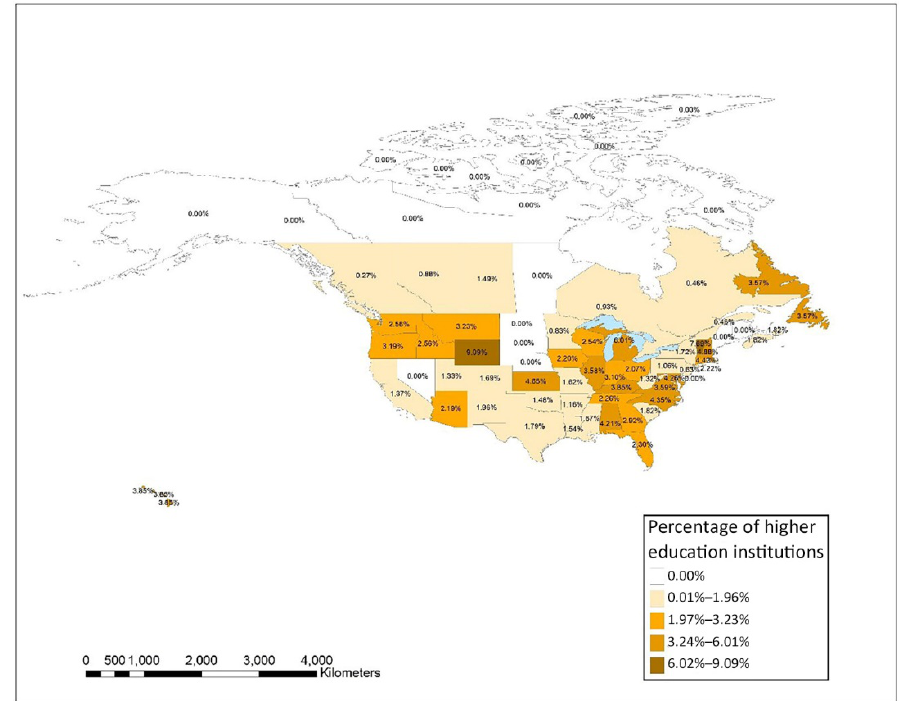
Figure 6 Distribution of higher education institutions in the United States and Canada with at least one JMLA author as a percentage of the total number of higher education institutions in each state or province